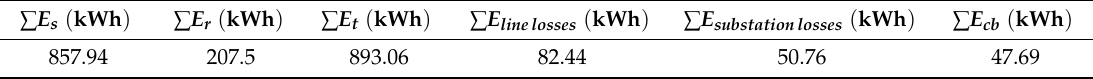
Table 2. Energy Consumption and Losses in the System.